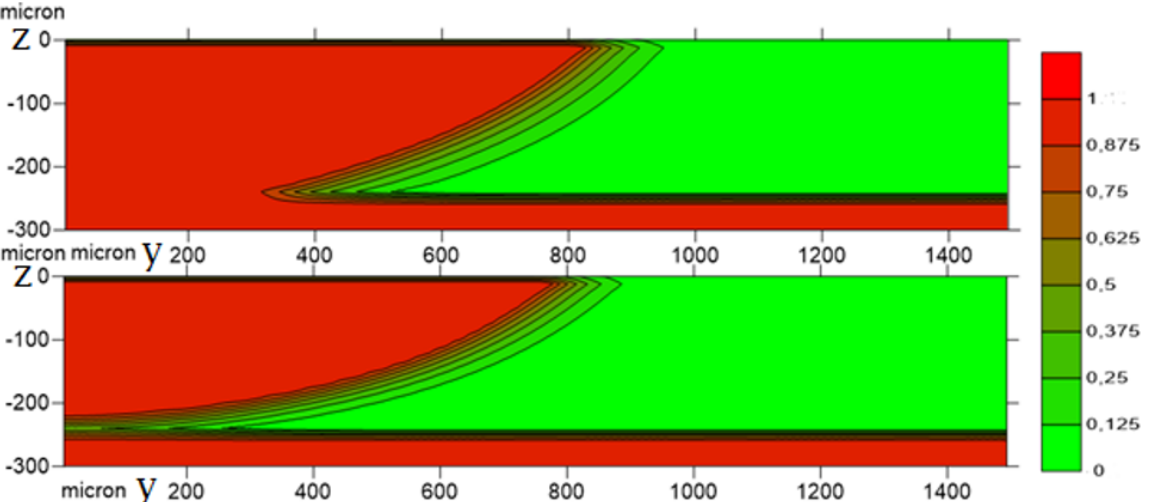
Fig.5. Sintering degree (χ2) for the modeled processes of laser melting of glass. On the top,ambient temperature = 1100K. Below, ambient temperature = 300